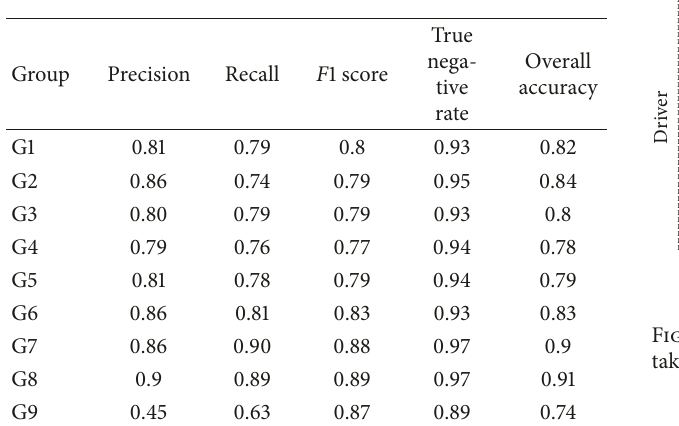
Table 4: Summary of driver identification scores for all groups.